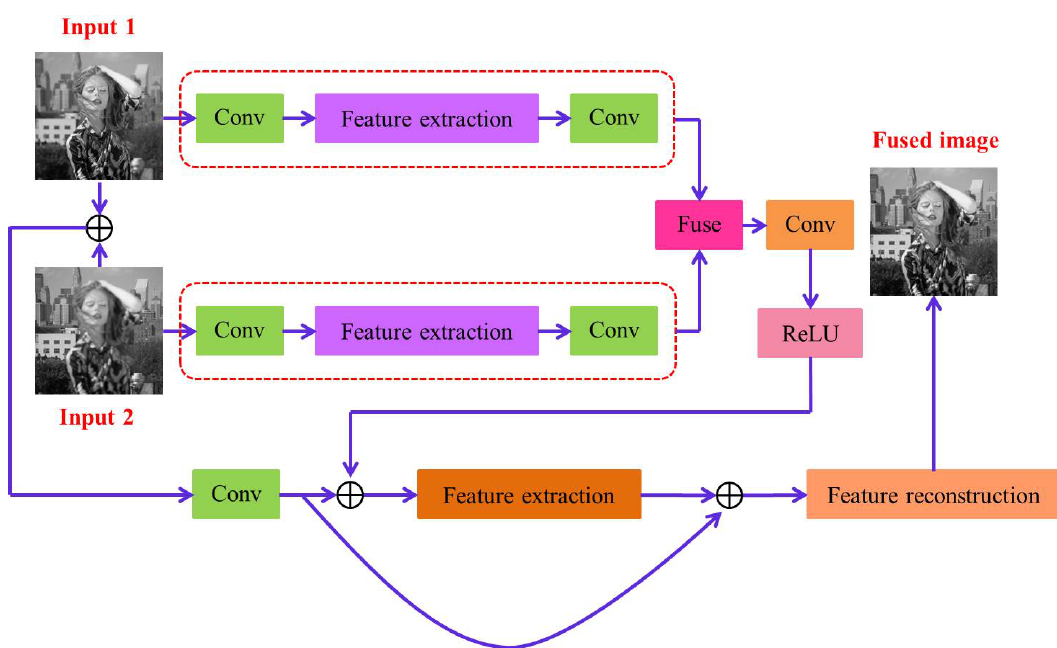
Figure 1. Detailed network architecture of our proposed multi-focus image fusion network. Our model constitutes three feature extraction networks for extracting non-linear features, a feature reconstruction layer for predicting the fused image, a convolutional layer for feature maps and fused features, and a transposed convolutional layer for obtaining the same dimensionality as the input